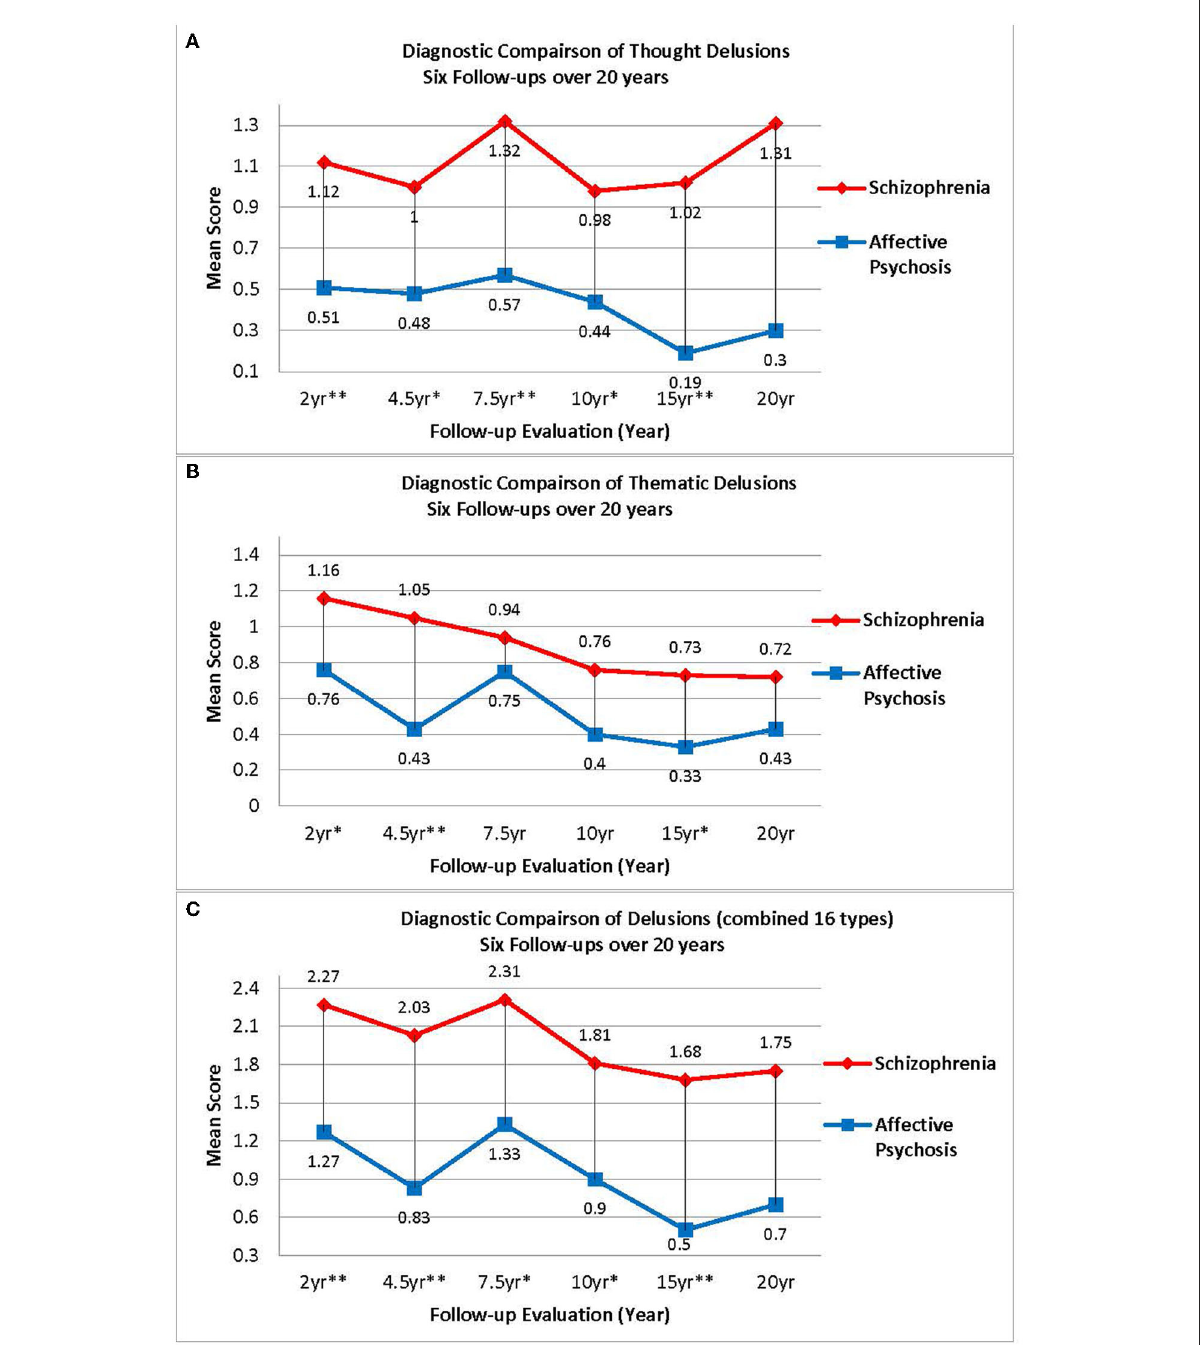
FIGURE3 (A) Diagnostic comparison of thought delusions six follow-ups over 20 years. (B) Diagnostic comparison of thematic delusions six follow-ups over 20 years. (C) Diagnostic comparison of delusions (combined 16 types) six follow-ups over 20 years. [ p -values for group effect at each time point were recorded as very significant ( p -value ≤ 0.01, 2 stars), significant ( ≤ 0.05, 1 star) or insignificant ( p -value > 0.05, no